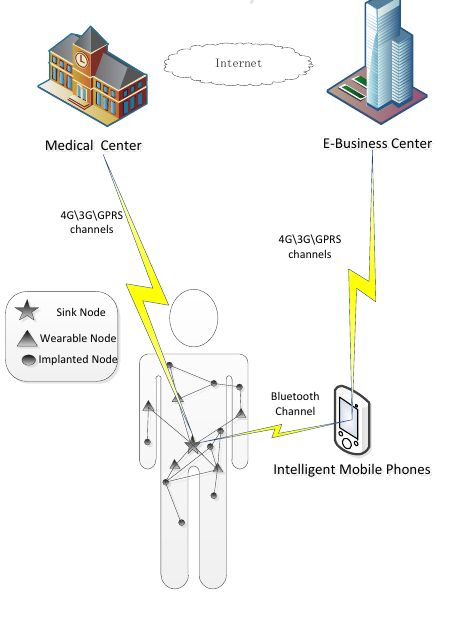
Figure 1. The structure of a BAN